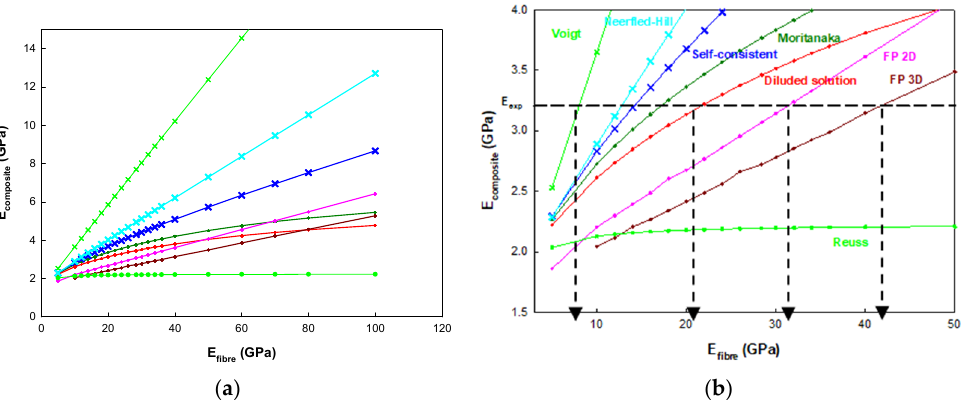
Figure 6. ( a ) Evolution of the Young’s modulus of the PP/alfa composite (30% by mass) as a function of the Young’s modulus of the alfa fiber for the different homogenization methods; ( b ) the reverse approach to estimate the Young’s modulus of the alfa fiber. Table 1. Results of the reverse approach for all of the studied homogenization methods.